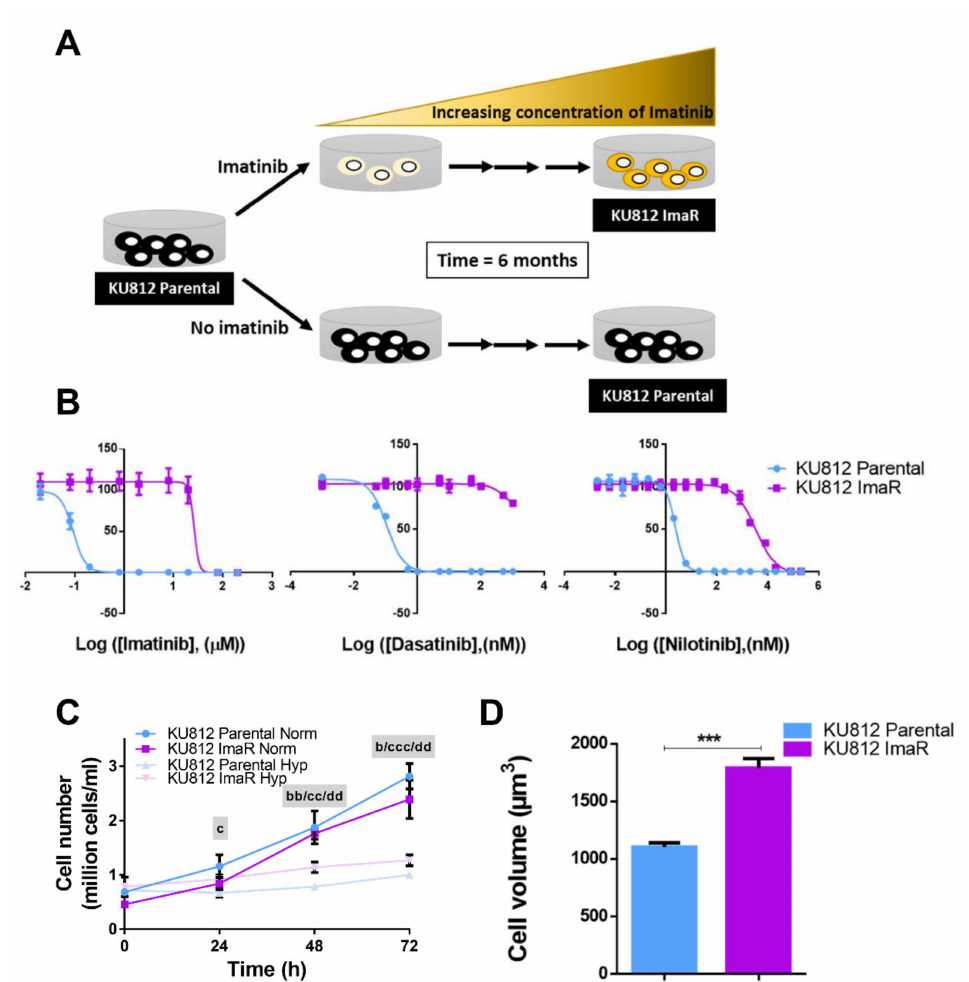
Figure 1. Phenotype, acquisition of TKIs resistance and changes in the principal biological processes of KU812 ImaR cells when compared with KU812 Parental cells. ( A ) Graphical description of the generation of an imatinib-resistant KU812 cell model (KU812 ImaR) under normoxia (Norm) by exposure of imatinib increasing concentrations. ( B ) Representative experiment (mean ± SD for n = 3 of n = 2 independent experiments) of the e ff ect of three di ff erent clinically-relevant tyrosine kinase inhibitors (TKIs) on the cell viability of KU812 Parental and ImaR cell. Cells were incubated for 72 h with DMSO (vehicle control) or increasing concentrations of the corresponding inhibitor. Viability of the cells at each concentration was analyzed, and the half-maximal inhibitory concentrations (IC 50 ) was determined. ( C ) Growth curve of KU812 parental and KU812 ImaR cells under normoxia and hypoxia (Hyp). The data represent mean ± SD for n = 3 of n = 2 independent experiments. Statistically significant di ff erences were determined by two-tailed independent sample Welch’s t -test between KU812 ImaR and KU812 Parental in hypoxia (b), KU812 Parental in normoxia vs. hypoxia (c), or KU812 ImaR in normoxia vs. hypoxia (d) ( p < 0.05 (b, c), p < 0.01 (bb, cc or dd), p < 0.001 (ccc). ( D ) Cell volume of KU812 P and KU812 ImaR cells under normoxia measured with the ScepterTM Handheld Automated Cell Counter. Statistically significant di ff erences in all the panels was determined by two-tailed independent sample Student’s t -tests: *** p <